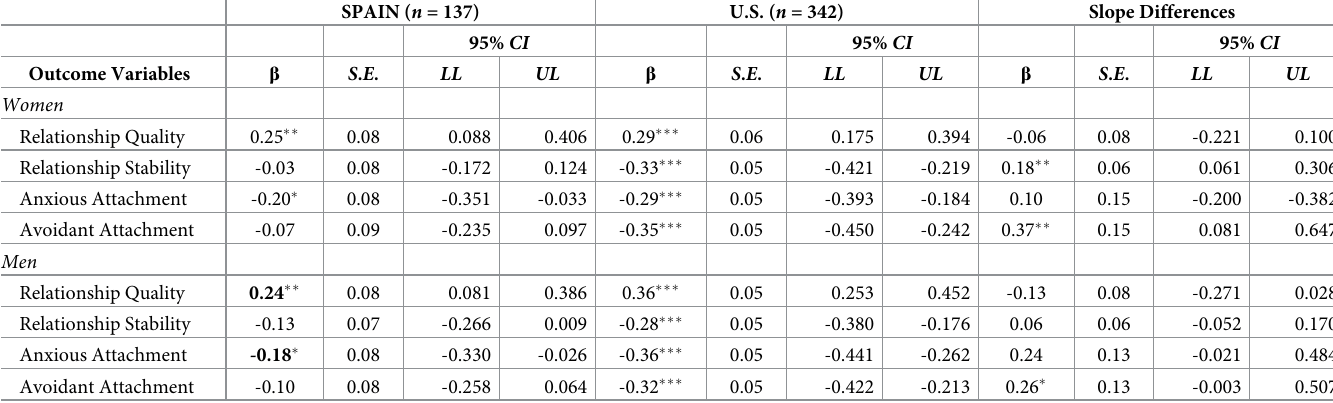
Table 5. Regression effects of women and men Time 1 combined differentiation of self scores on Time 2 outcome variables for couples from Spain and the U.S., and cultural differences among the